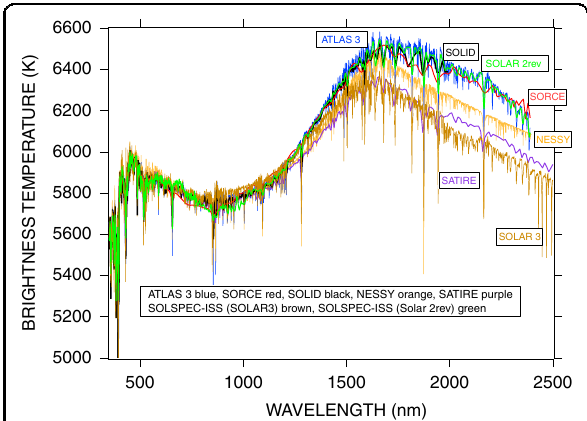
Fig. 8 Brightness temperature in the visible-to-IR range for the seven spectra used in this